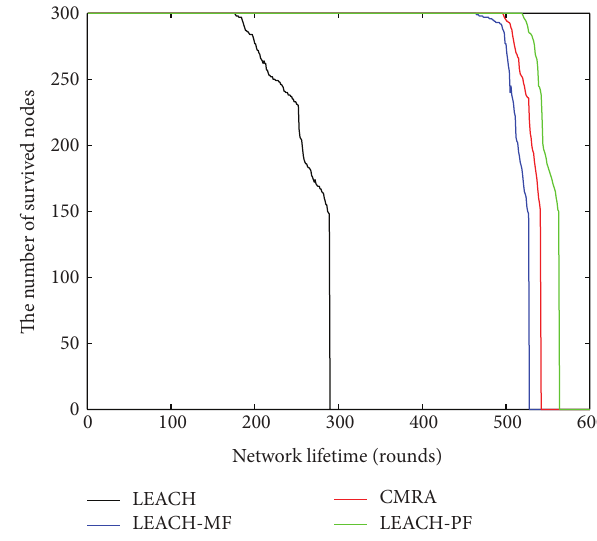
Figure 4: Four algorithms increase with the number of rounds remaining nodes.